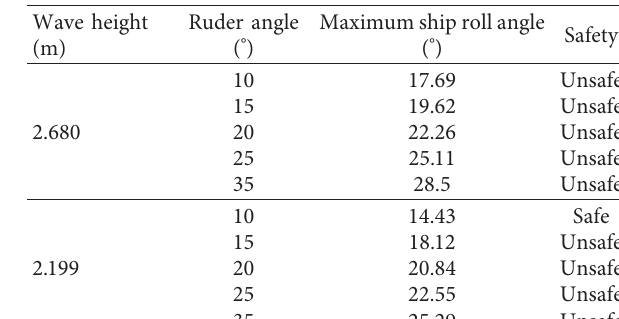
Table 9: Relationship between the steering angle and the maximum roll angle at the initial speed of